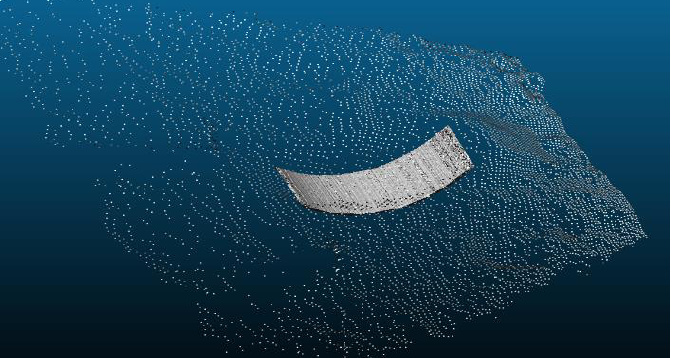
Figure 9. The final reconstruction map for occluded areas using proprioceptive and exteroceptive sensing data.